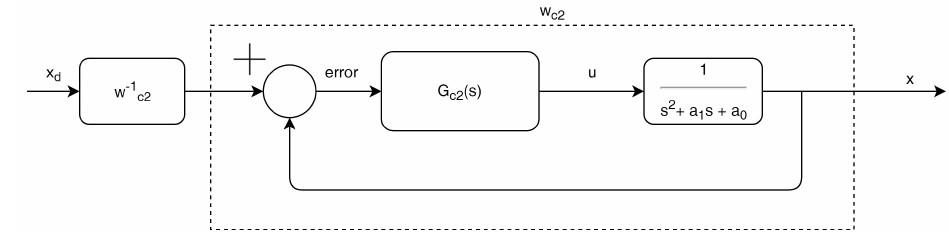
Figure 5. Closed loop transfer